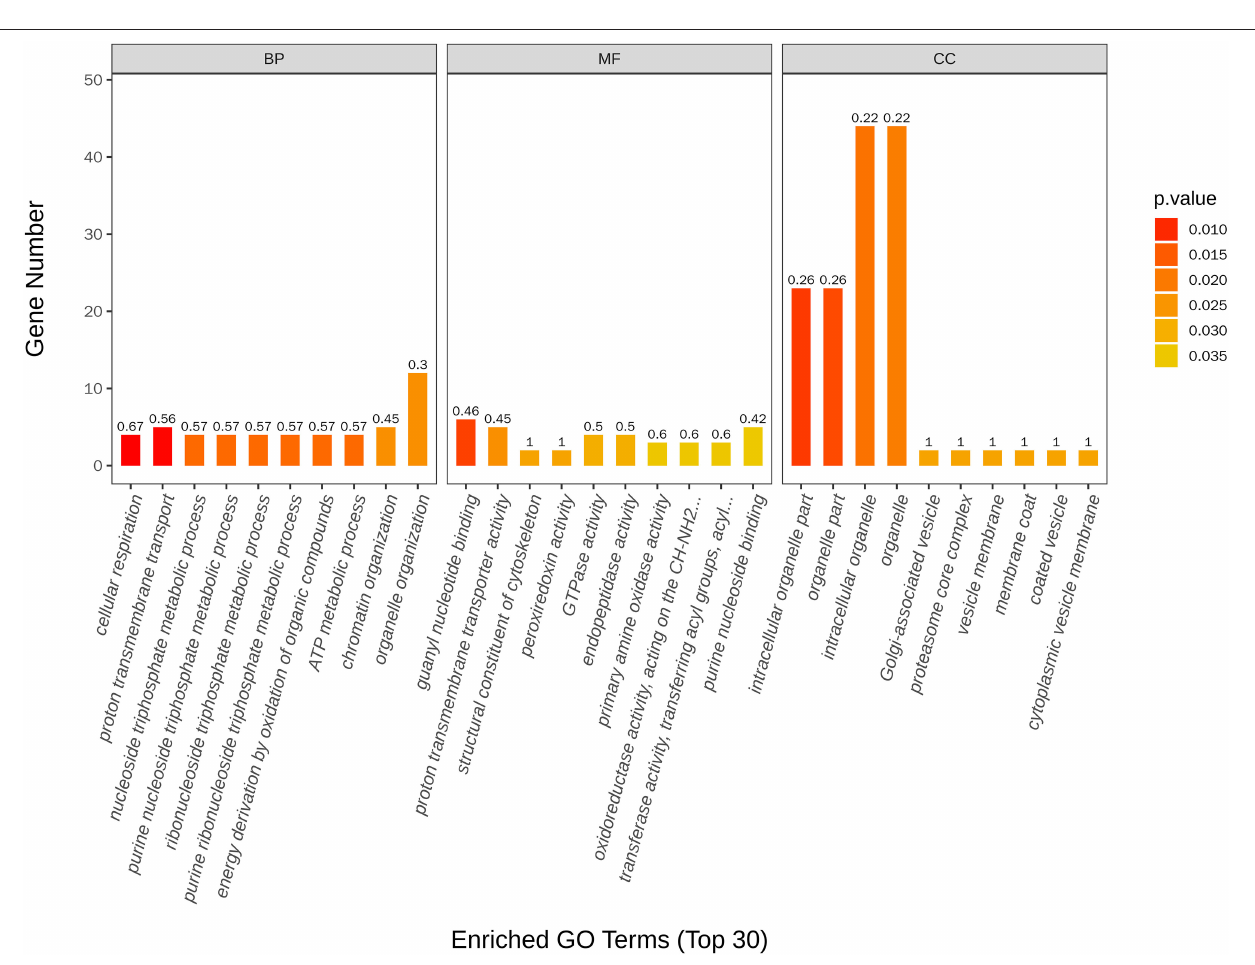
and pathway responses in P. digitatum cells treated by antifungal agent [(41,